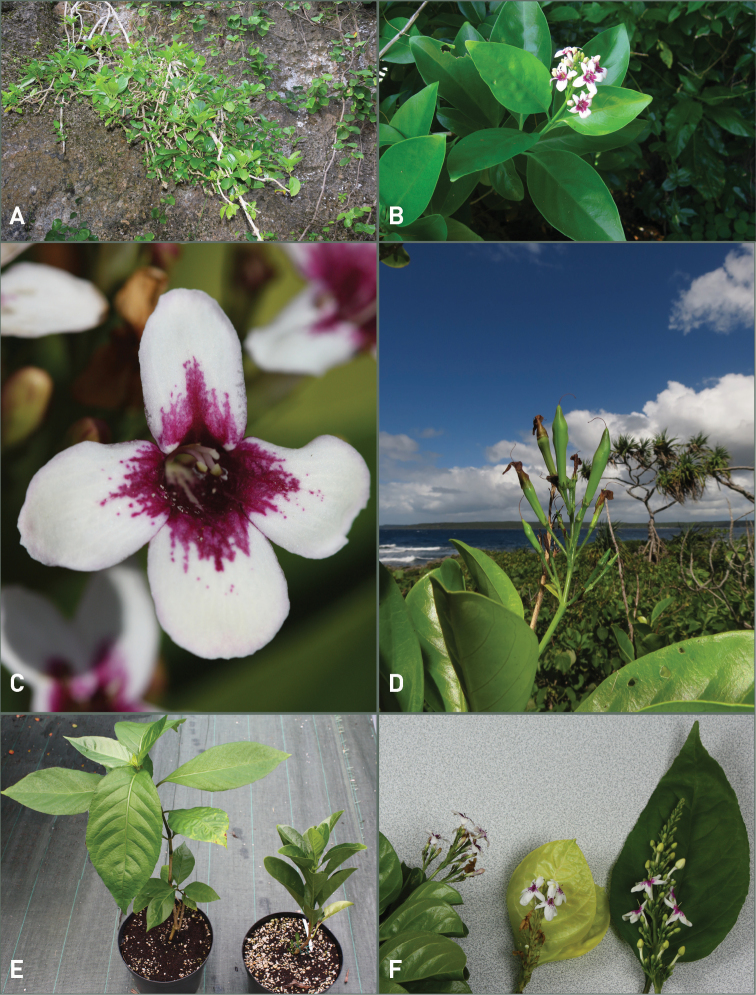
Field pictures of Pseuderanthemum
melanesicum Gâteblé, Ramon & Butaud, sp. nov. and P.
carruthersiiA–D. Pseuderanthemum
melanesicumE–FPseuderanthemum
melanesicum and P.
carruthersiiA Overview of a single shrub hanging from a coastal limestone cliff on Maré island B Flowering branch on Efaté island C Flower D Infructescence and ecology on Lifou island E Cultivated plants of P.
carruthersii (left) and P.
melanesicum (right) F Leaves and inflorescences of P.
melanesicum (left) and two cultigens of P.
carruthersii (center and right). Photographs by G. Gâteblé (A, C, E–F), L. Ramon (B) and J.-F. Butaud (D); Voucher specimens: AGâteblé et al. 1024, BRamon 220, CGâteblé 722, FGâteblé 722, 721, 720.